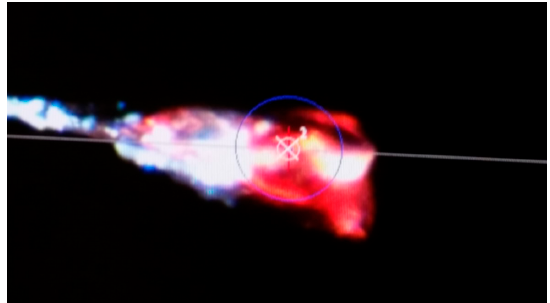
Figure 3. Snapshot of the avidin/B9P crystal made during data collection.